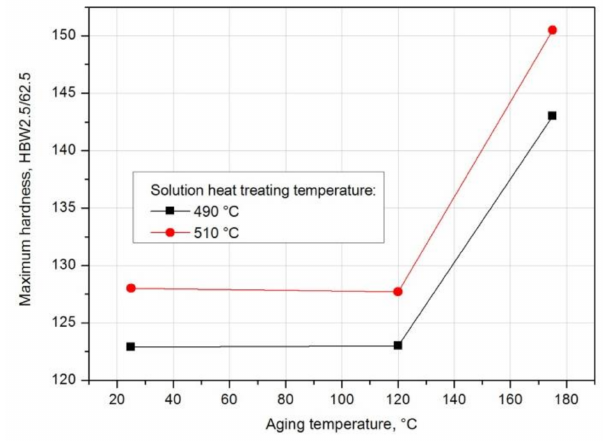
Figure 19. Effect of aging temperature and time on the change in the hardness of an alloy solution heat treated from 490 ◦ C and aged naturally and artificially.